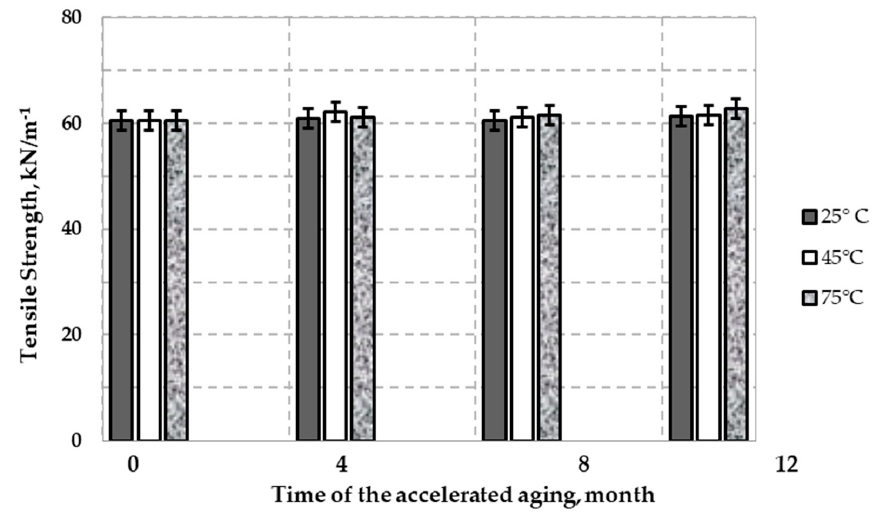
Figure 8. Variation of tensile strength (T)HDPE geogrid sample with time in leachate at three temperatures: 25 °C, 45 °C, and 75 °C.